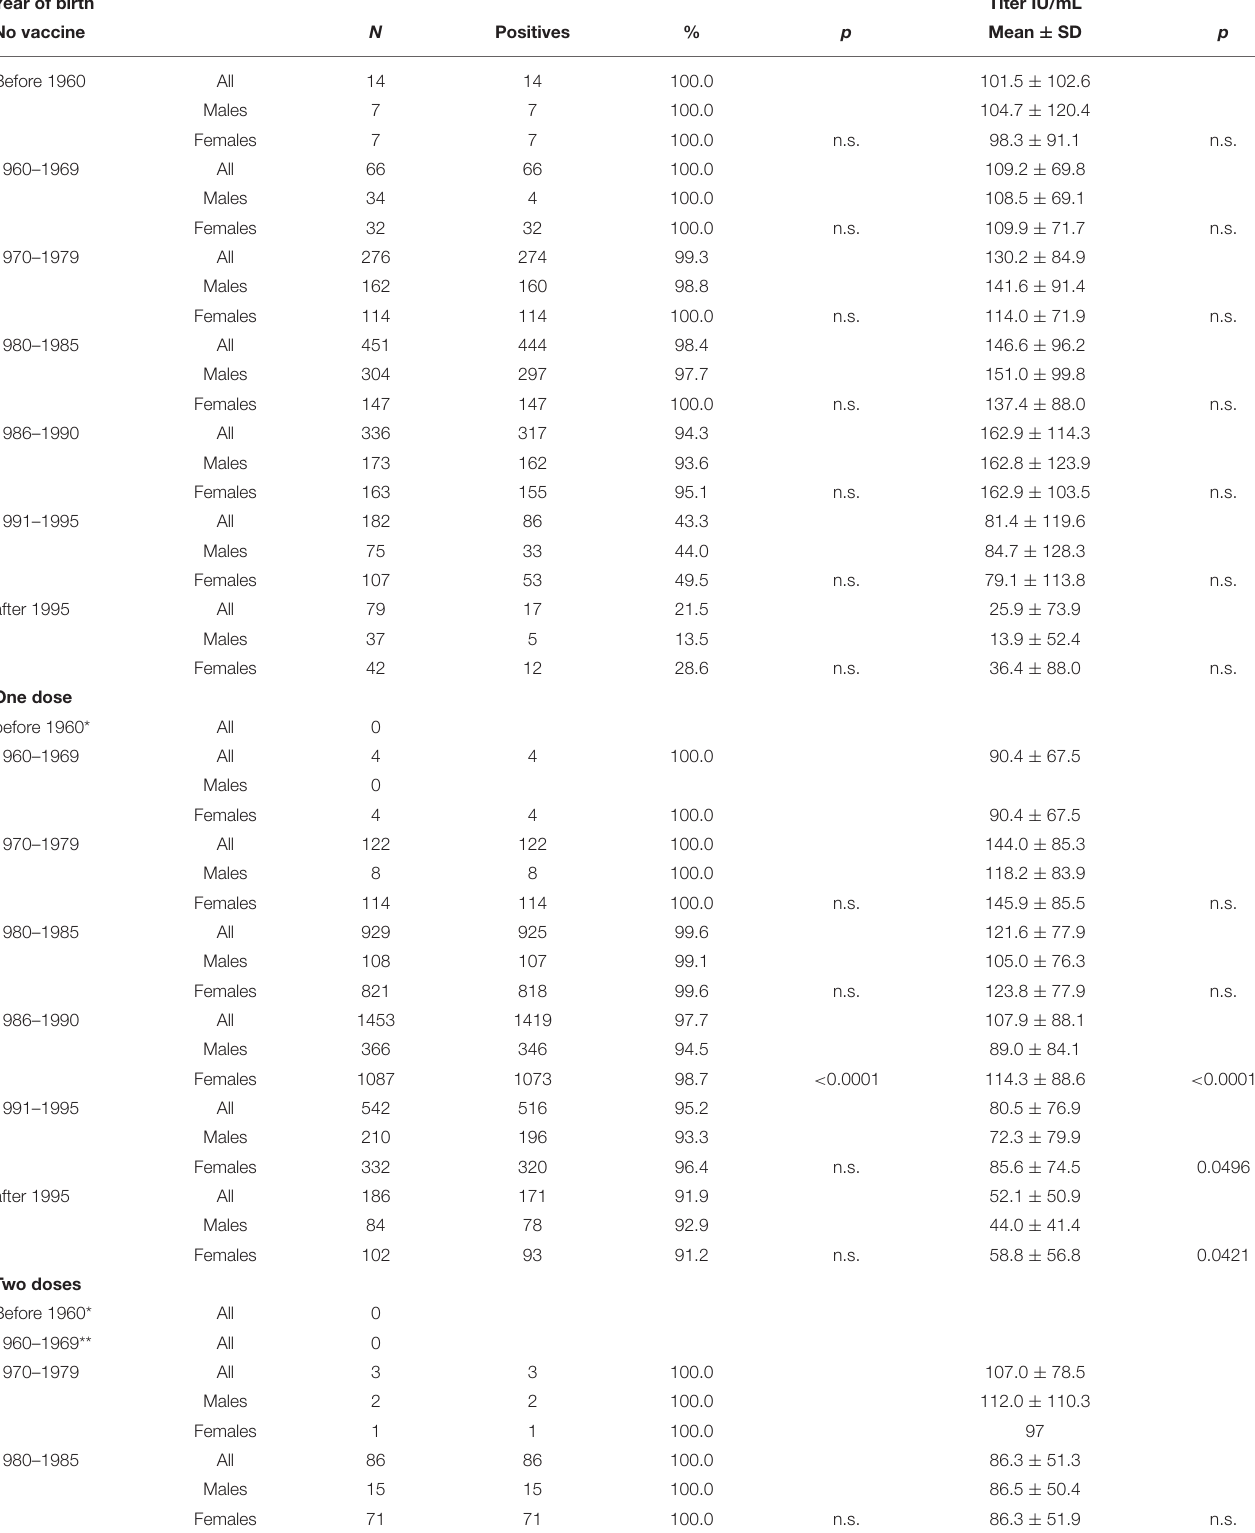
TABLE 2 | Characteristics of antibodies against rubella in terms of positivity percentage and antibody titer. Year of